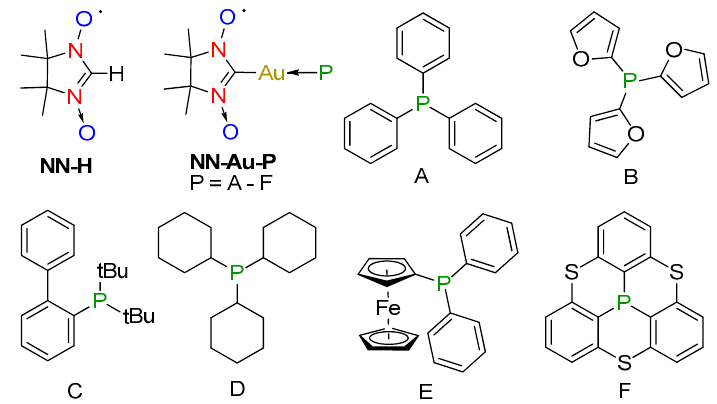
Figure 1. Previously reported NN-Au-phosphine organometallic derivatives.